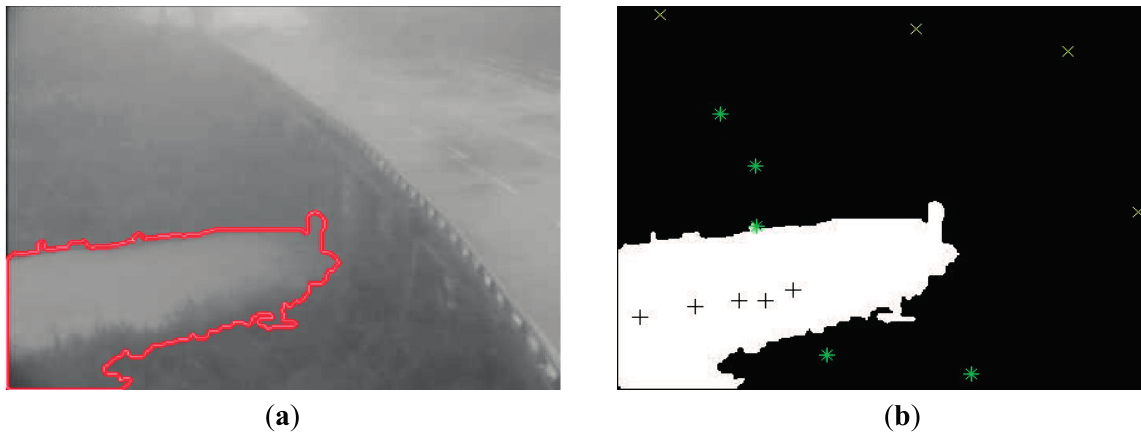
Figure 3. Example of flood region detection. Figure ( a ) shows the detection result for the river water region, indicated by the red boundary. In Figure ( b ), the white area denotes the flood region, foreground seed points are represented by black plus signs (+), background seed points are represented by yellow “x” symbols, and the user preset warning points are represented by green asterisk symbols (*). In this example, none of the preset warning points are intruded by water; therefore, the risk is